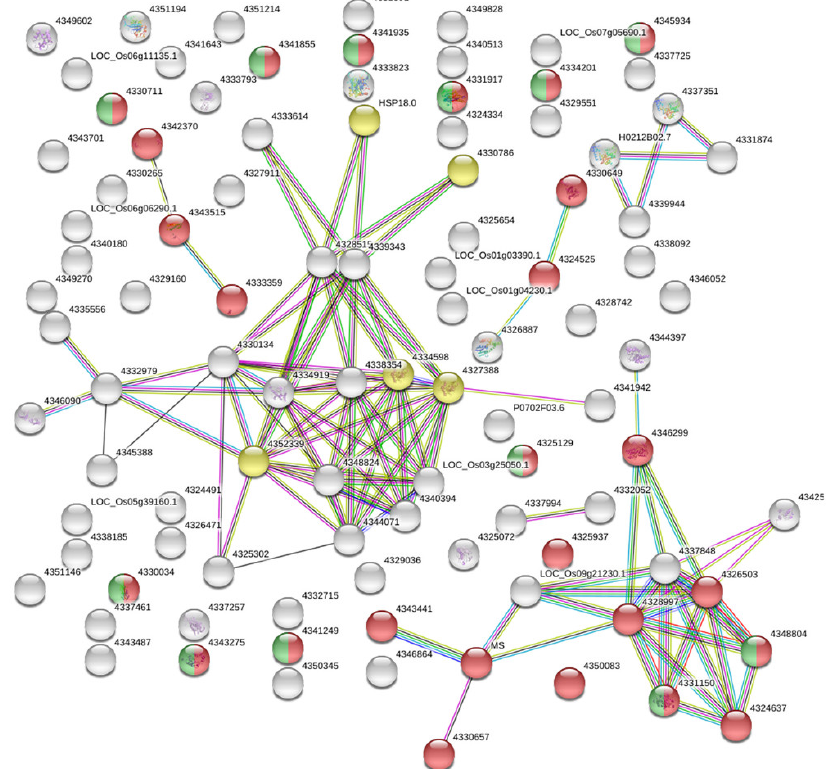
Figure 3. The protein–protein interaction network of the cor-DEGs-DAPs protein analyzed by STRING software. The red circles represent ‘metabolic pathways’; the green circles represent ‘biosynthesis of secondary metabolites’; and the yellow circles represent ‘protein processing in endoplasmic reticulum’. The genes are color-coded by their clustering, as determined by the MCL (Markov Clustering algorithm) clustering inflation parameter of 3. The cor-DEGs-DAPs proteins are represented by node, whereas di ff erent colored lines represent di ff erent evidences for the predicted functional relationship between proteins; red line: gene fusion evidence; dark blue line: co-occurrence evidence; black line: co-expression evidence; yellow line: text-mining evidence; green line: neighborhood genome evidence; light blue line: database evidence; and pink line: experimental evidence.